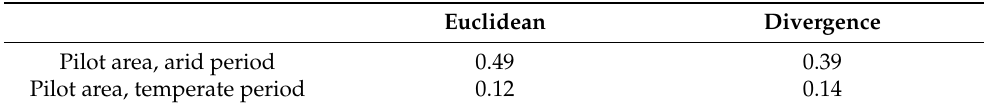
Table 3. Average normalized spectral separability using all the spectral bands for both the Euclidean and the divergence metrics in the arid and temperate periods.